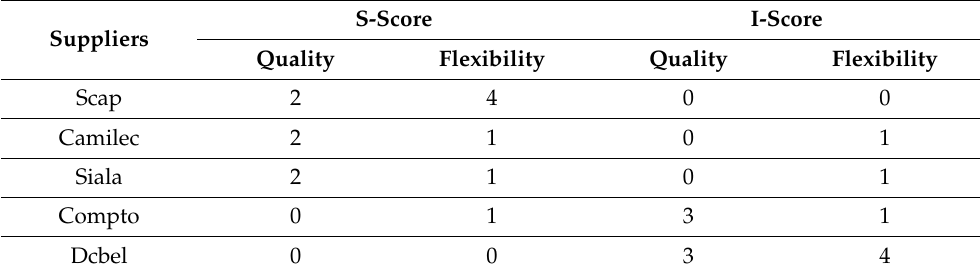
Table 5. The Superiority and Inferiority Scores Matrix.